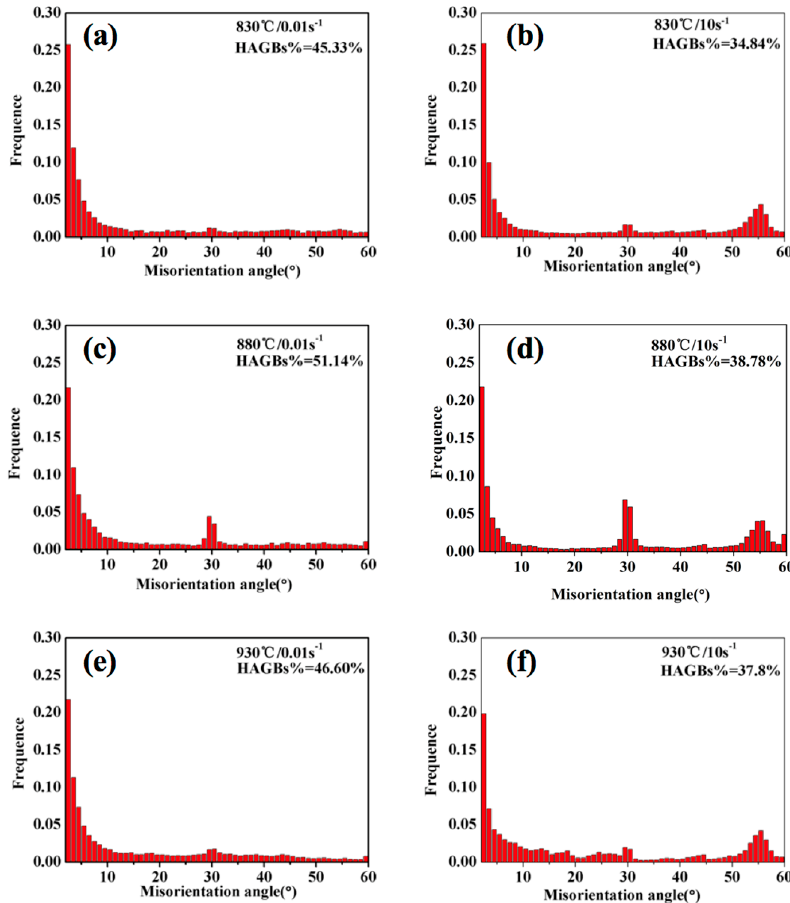
Figure 16. The relative fraction of LAGBs and HAGBs under different deformation conditions of the β phase region: ( a ) 830 °C, 0.01 s − 1 ; ( b ) 880 °C, 0.01 s − 1 ; ( c ) 930 °C, 0.01 s − 1 ; ( d ) 830 °C, 10 s − 1 ; ( e ) 880 °C, 10 s − 1 ; ( f ) 930 °C, 10 s − 1 .